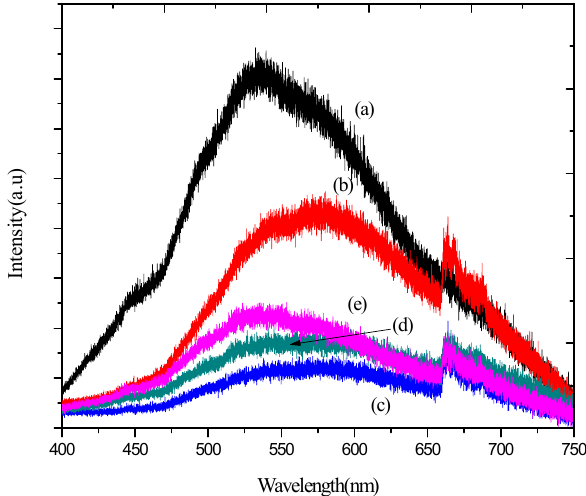
Figure 10. Photoluminescence spectra of CuTiO 2 NTs ( a ) Cu ‐ 00; ( b ) Cu ‐ 01; ( c ) Cu ‐ 02; ( d ) Cu ‐ 03; ( e ) Cu ‐ 04.